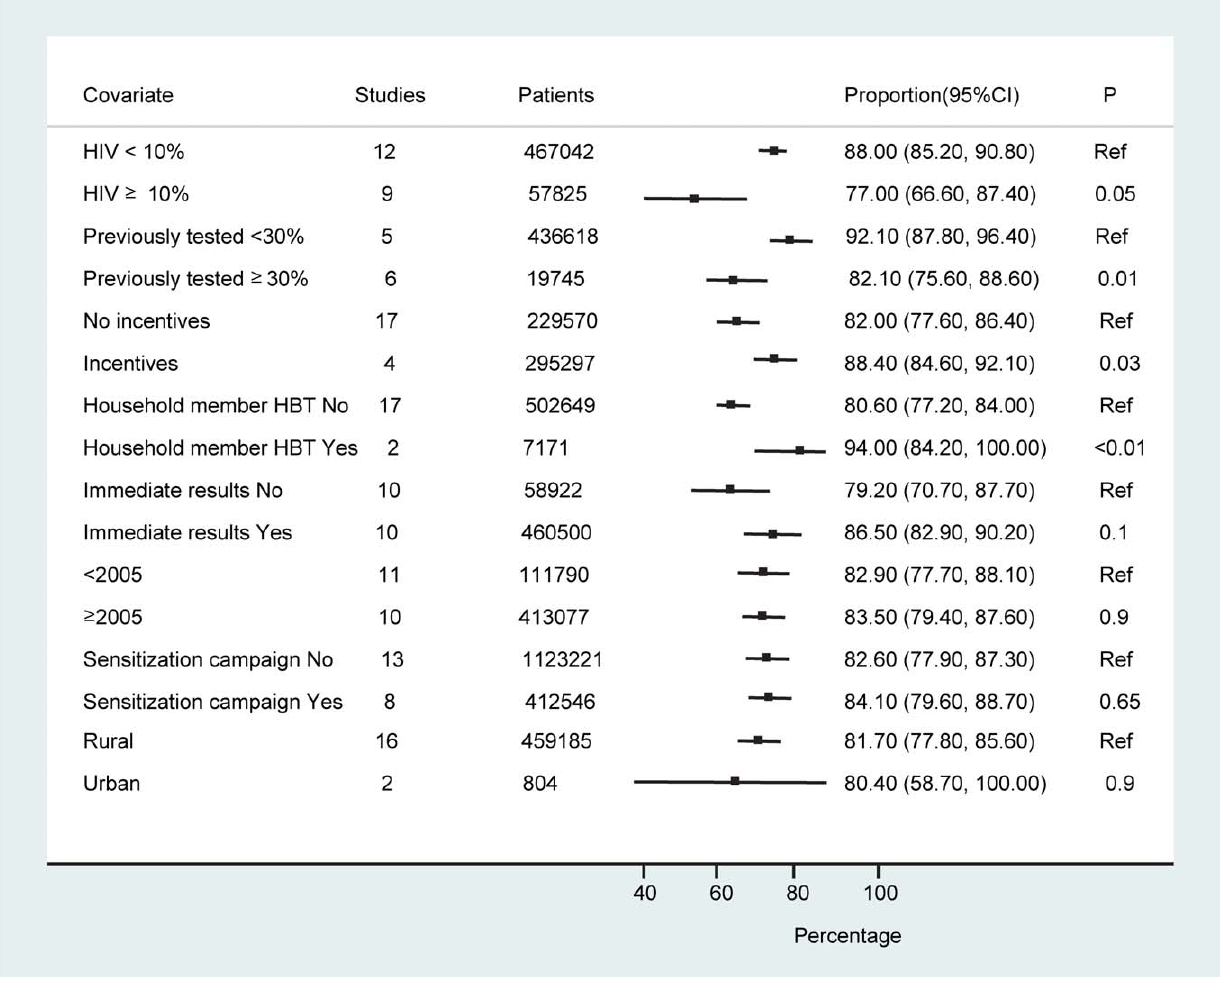
Figure 4. Sub-group analyses.